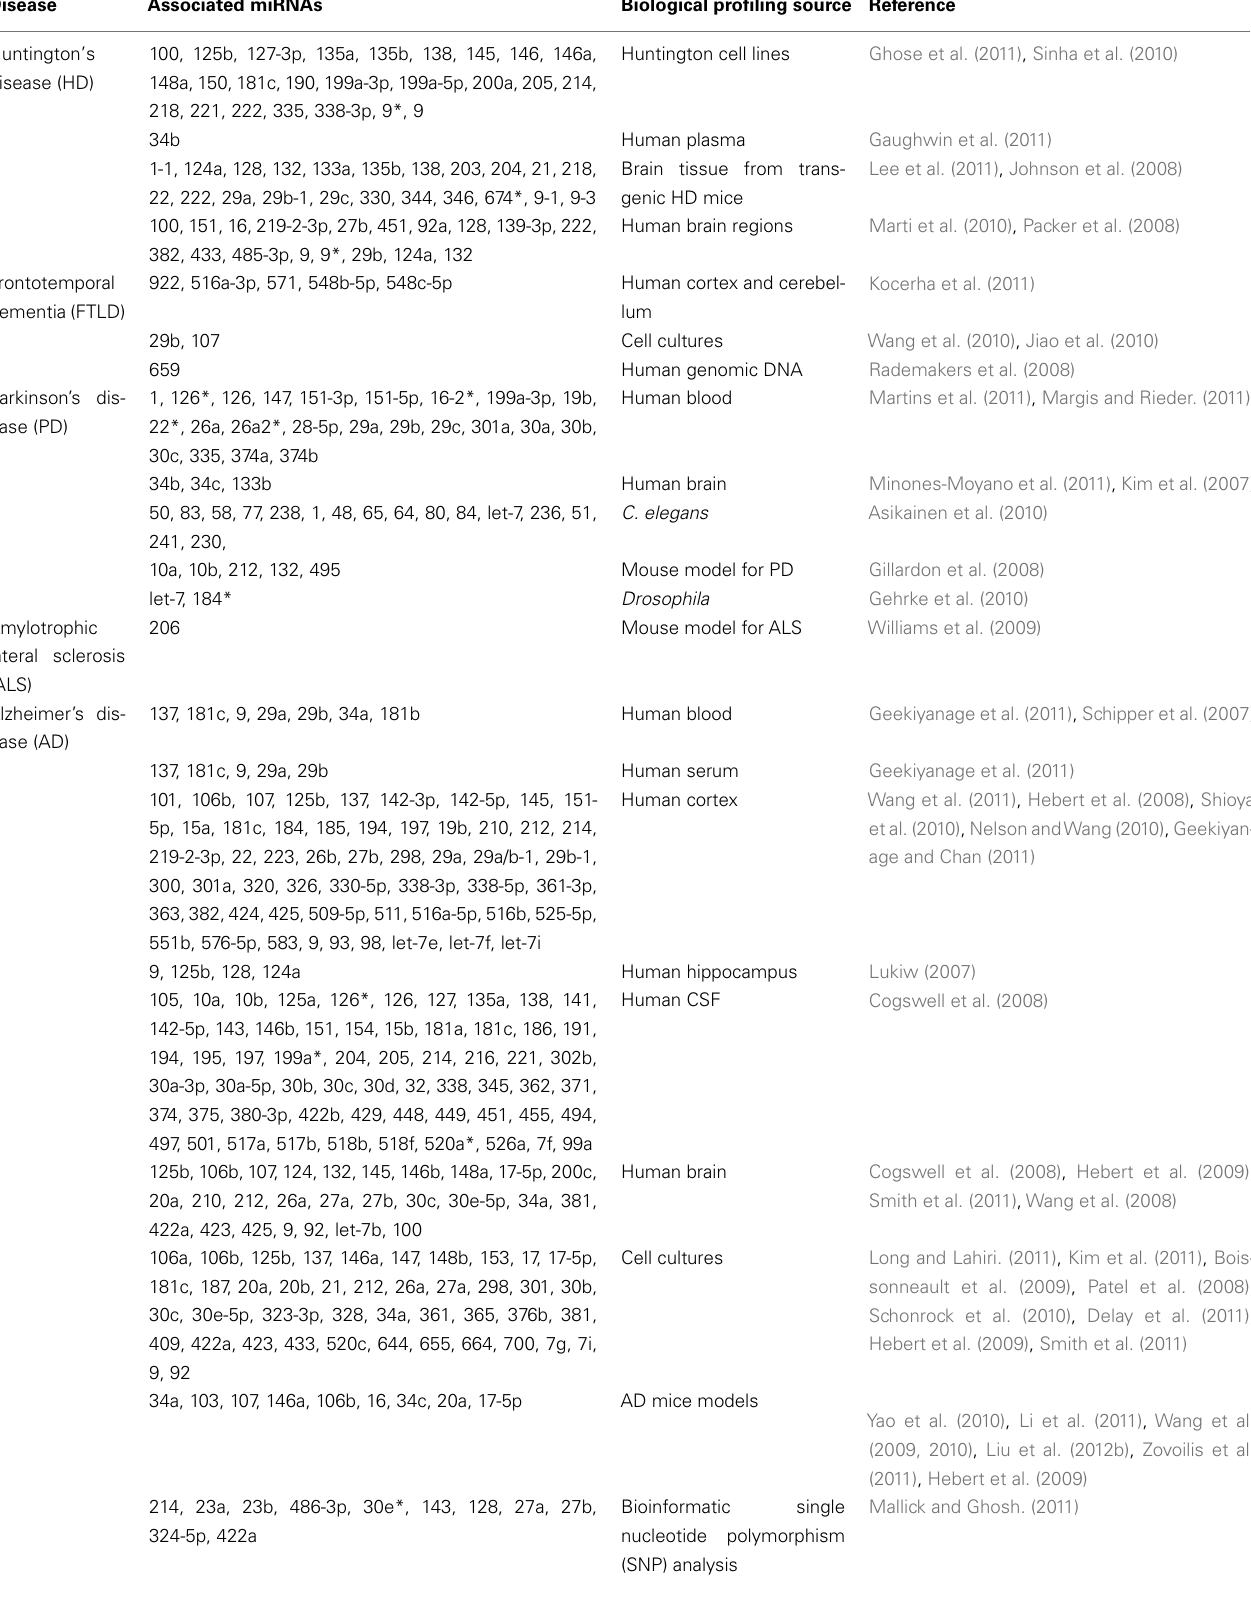
Table 2 | miRNAs associated with neurodegenerative disease.